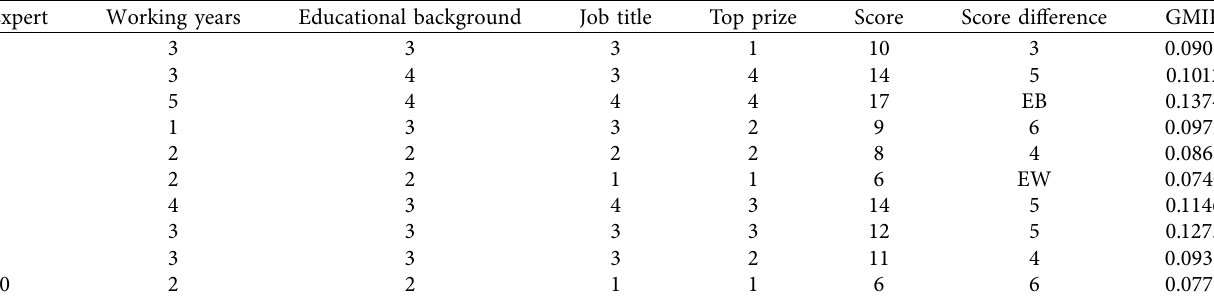
Table 10: Expert index